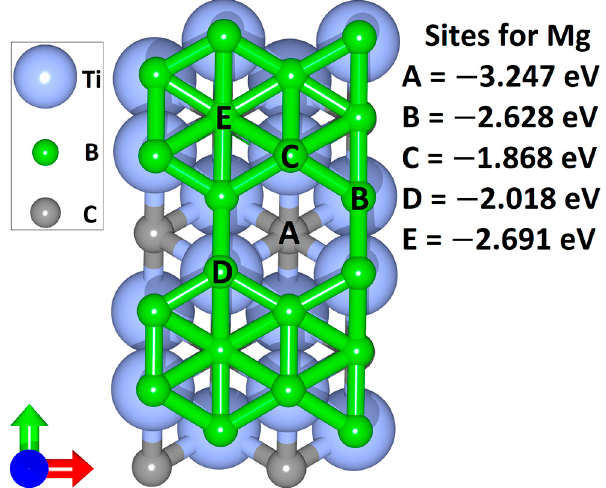
Figure 3. Variants of the arrangement of the Mg atom on the surface of the Ti 16 C 8 B 40 composite material (the Mg atom is not shown in the figure).